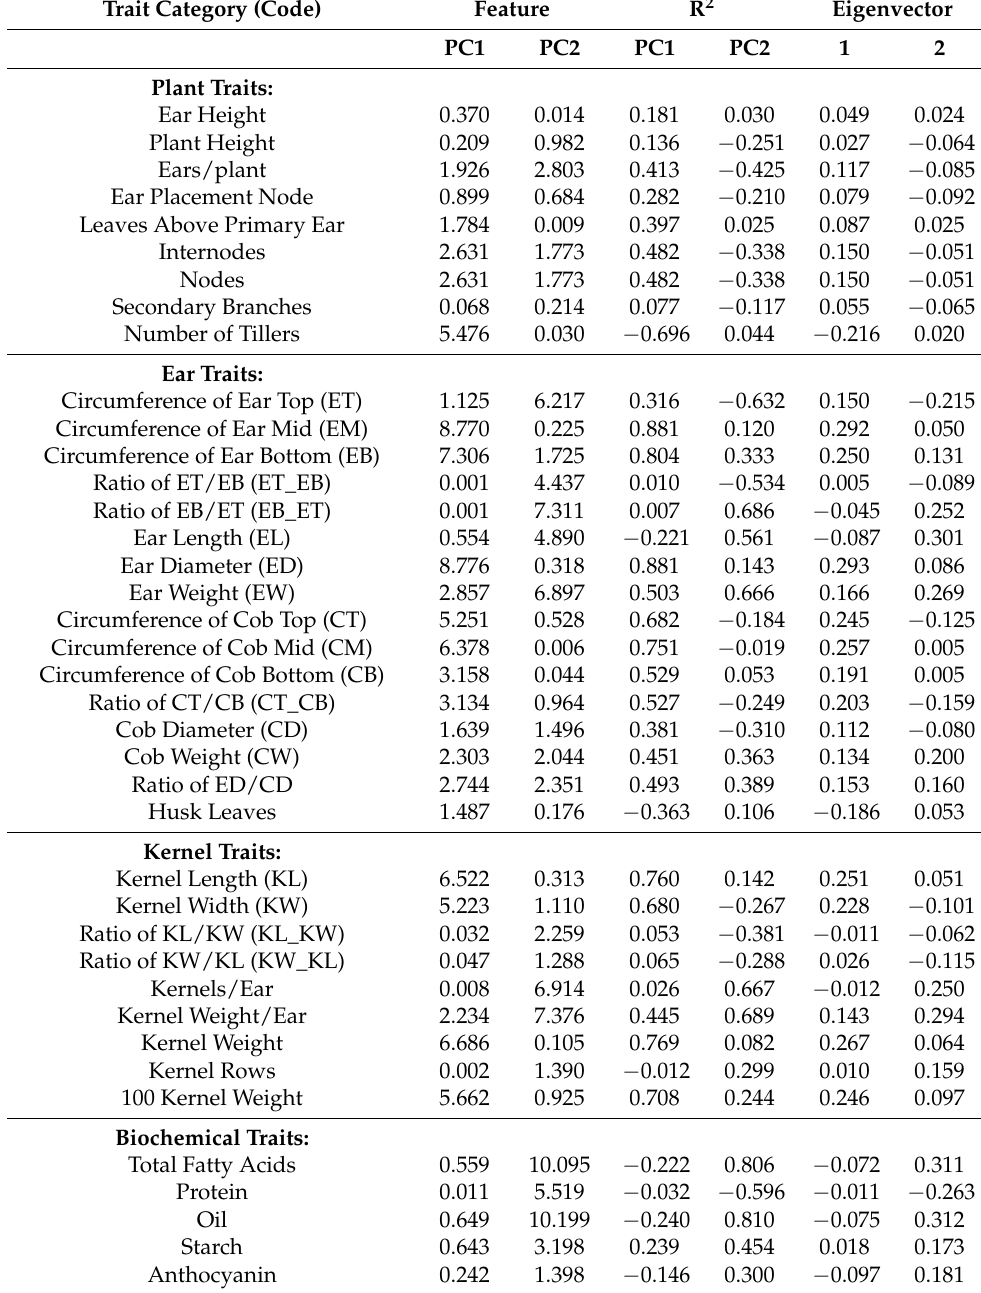
Table 6. Agro-morphological and biochemical trait contribution, correlation coefficient, and eigen vector for principle component 1 and